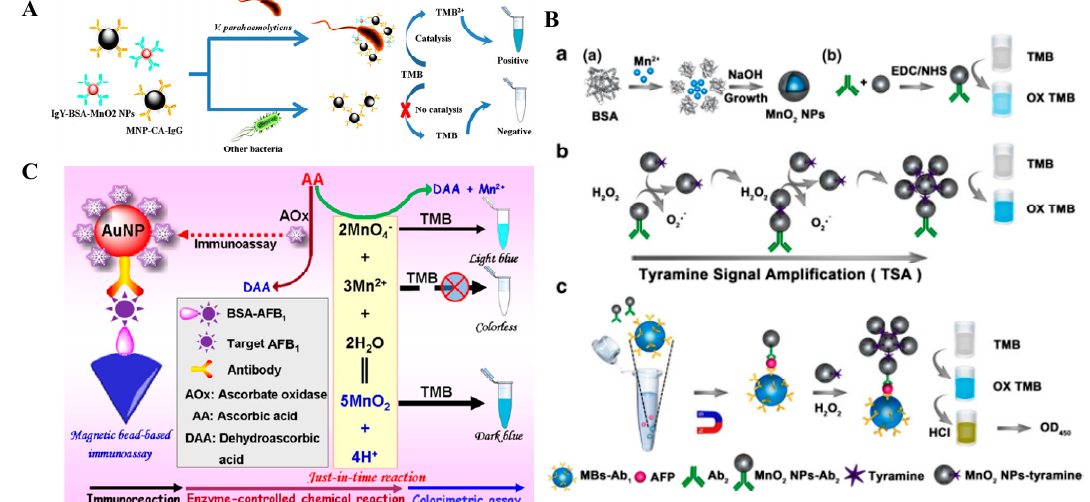
Figure 6. ( A ) Schematic diagram for the immunomagnetic capture and colorimetric detection of V. parahaemolyticus . Reproduced with permission from [75]. Copyright Springer Nature, 2017. ( B ) The principles and procedures of the MnO 2 NPs based immunosensor for α -fetoprotein (AFP) detection. (a) Schematic procedures for preparation of BSA-MnO 2 NPs and Ab 2 -MnO 2 NPs conjugate; (b) Schematic illustration for the tyramine signal amplification (TSA) system; (c) procedures for AFP detection through the MnO 2 NPs-based immunosensor combined with magnetic separation. Reproduced with permission from [76]. Copyright Springer Nature, 2017. ( C ) Schematic illustration of the conventional chemical reaction for an unconventional application in the magnetically responsive colorimetric immunoassay using enzyme-responsive just-in-time generation of MnO 2 nanocatalyst. Reproduced with permission from [77]. Copyright Springer Nature,